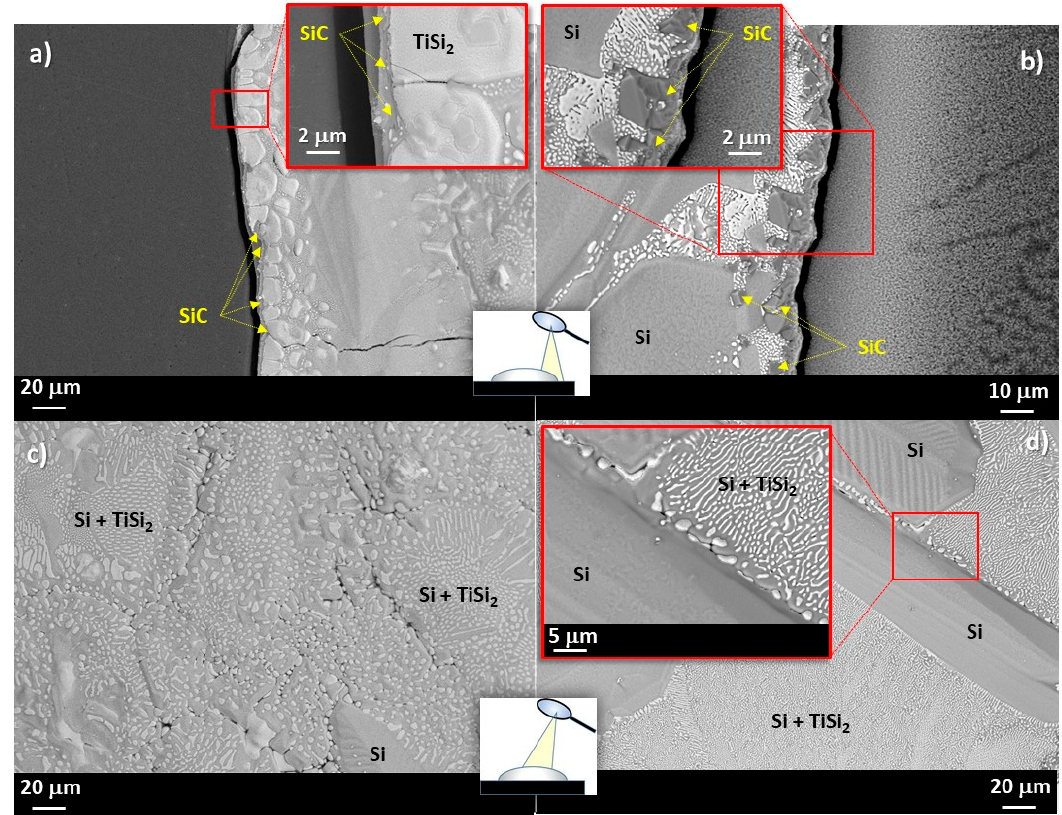
Figure 4. SEM-BSE images and proposed phase identification by EDS analyses performed at different magnifications at the triple lines and at top of the ( a , c ) Si-24at%Ti/GC and ( b , d ) Si-8at%Ti/GC samples after the wetting tests performed at T = 1450 °C for 15 min.